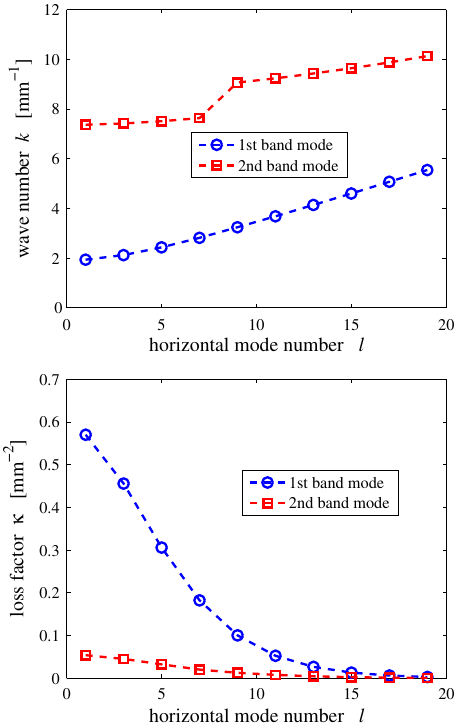
FIG. 7. Relative increase in the wakefield amplitude after including the second band modes as functions of a=h , for different h=p . Here p; g , have the nominal values of Table